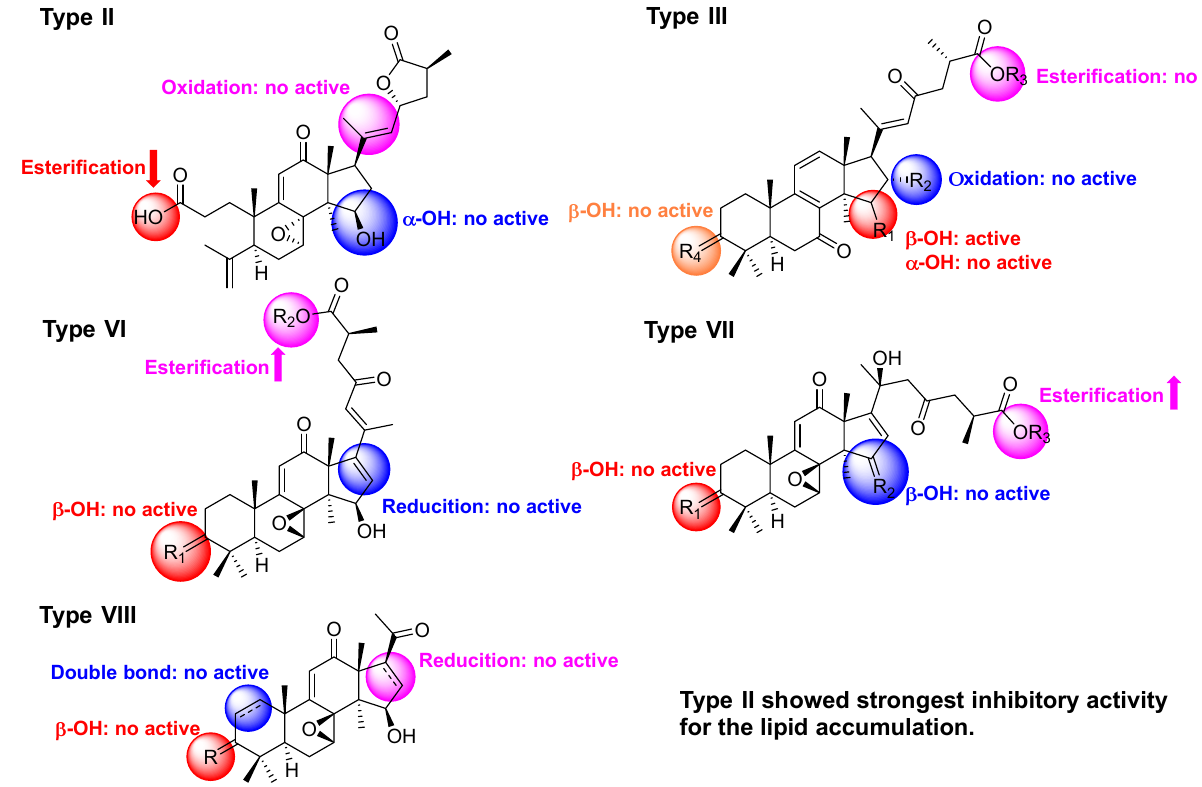
Figure 6. The proposed structure–activity relationship of triterpenoids from G. applanatum.